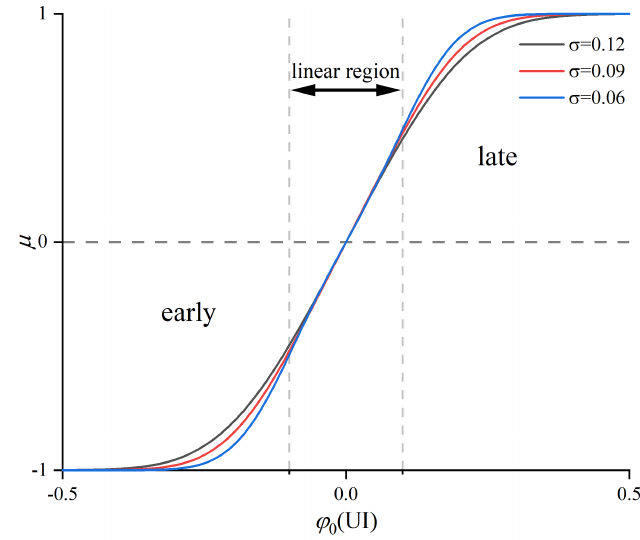
Figure 13. Average output voltage of PD with various